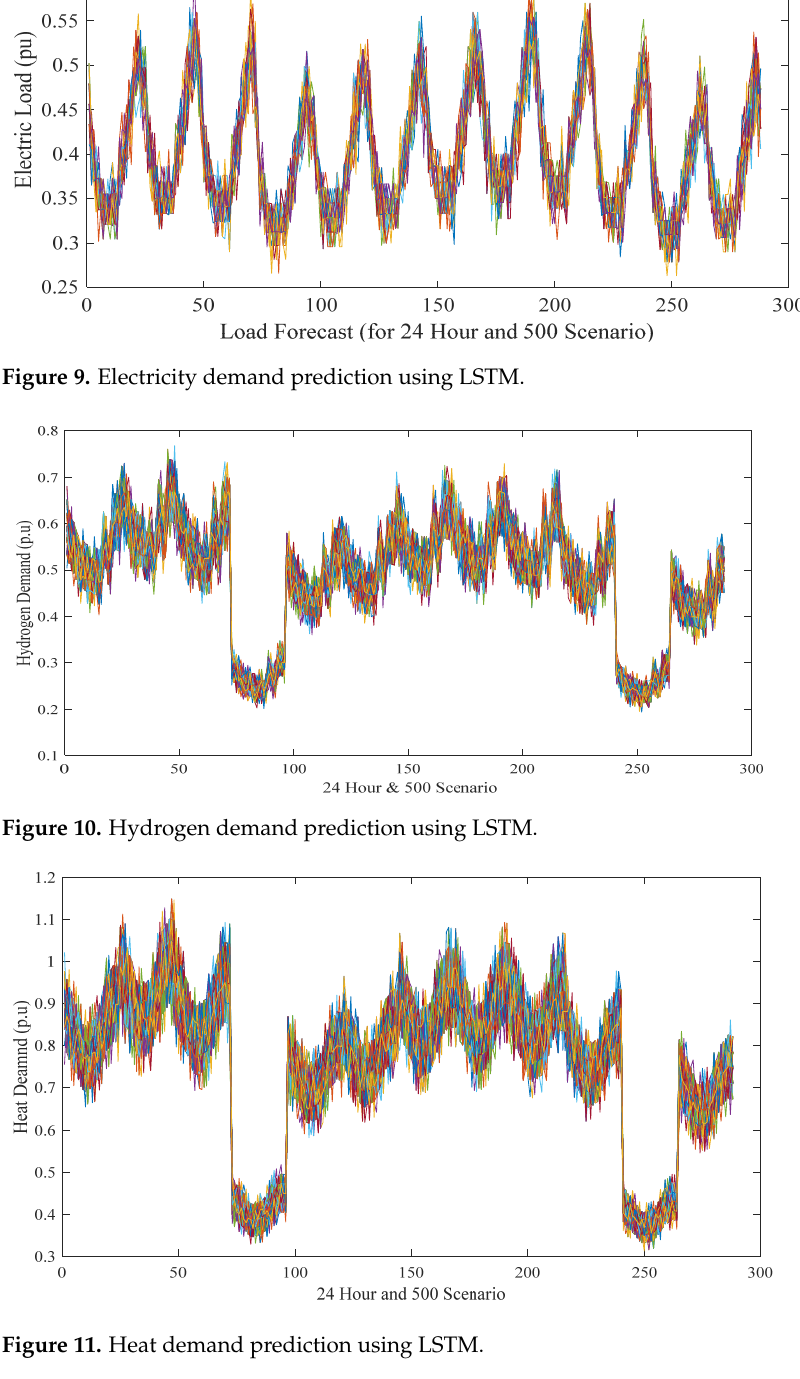
Figure 12. Sun irradiation prediction using LSTM.